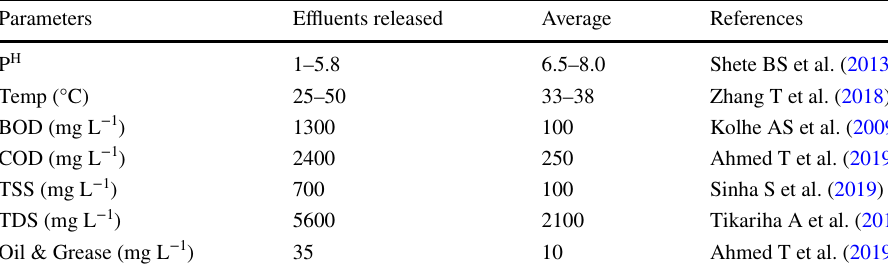
Table 5 Parameters in dairy industry effluent (data provided in this table has been updated)